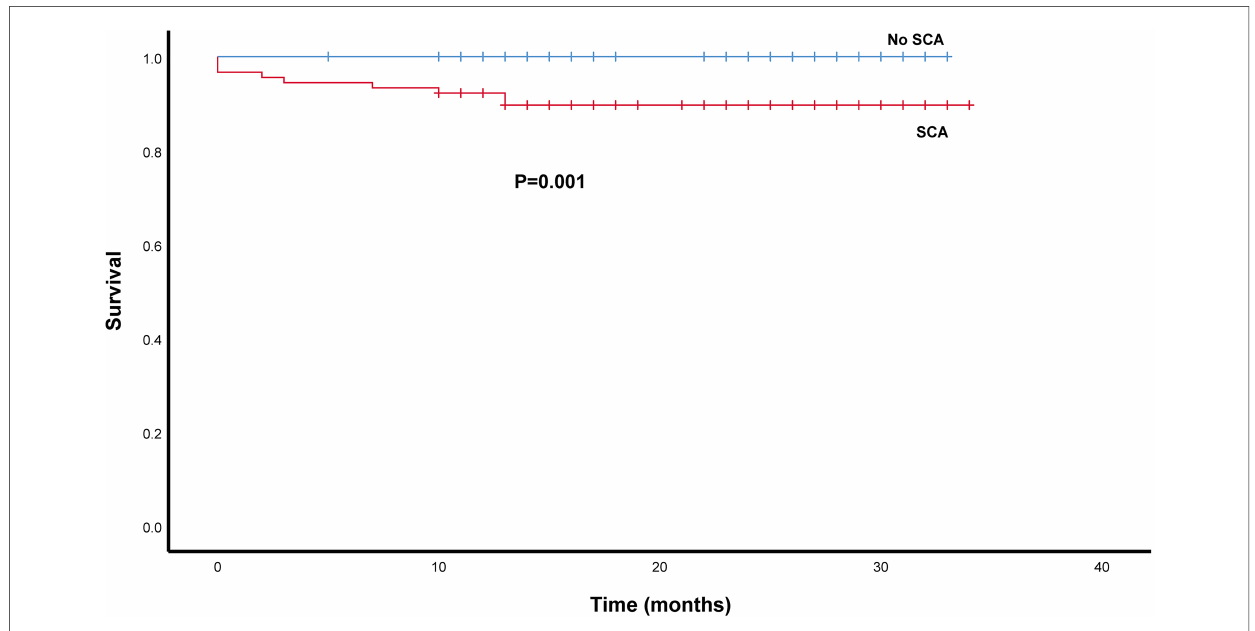
FIGURE 4 Survival analysis of SCA patients after LT using the kaplan – meier method. The patients survival rate was lower in the SCA group than in the non -SCA group (log-rank P